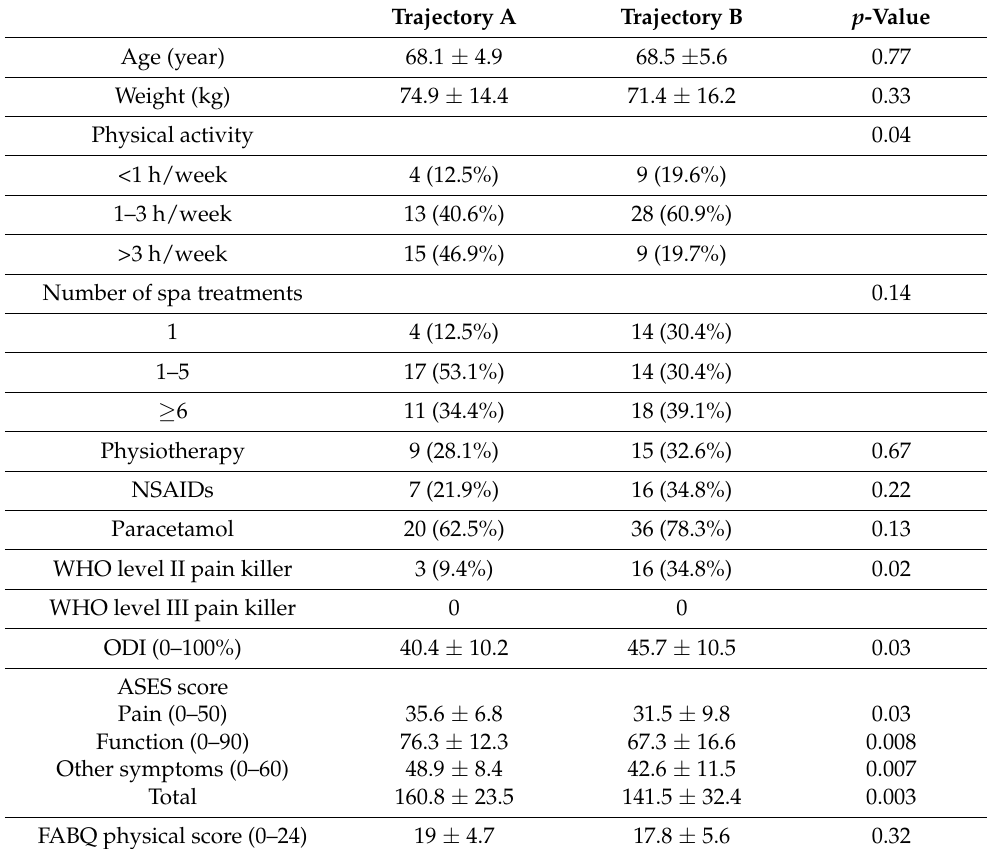
Table 2. Pain trajectories ( n = 77).